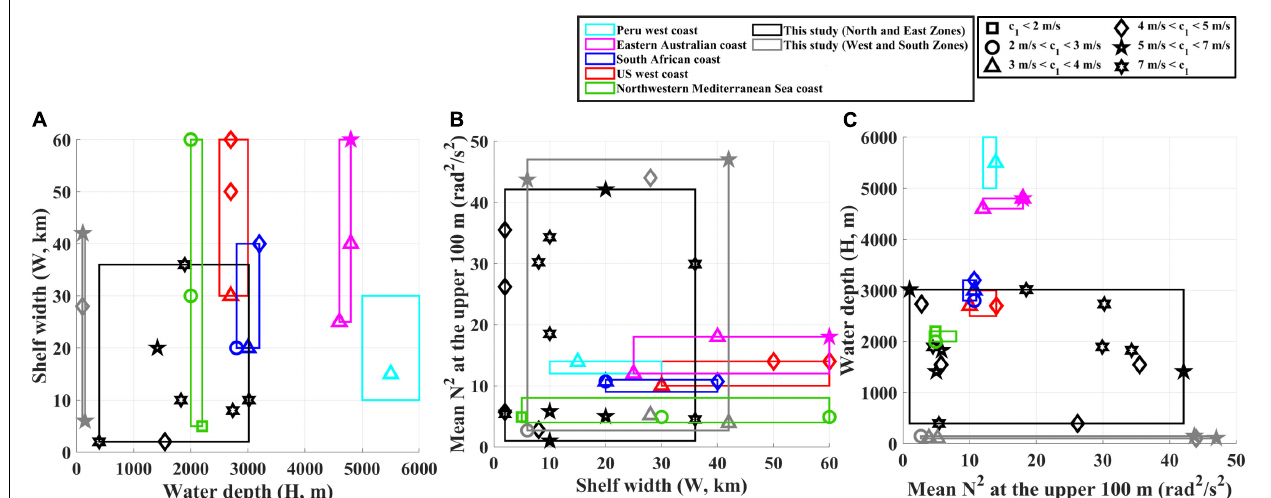
FIGURE 9 | Comparison of mode-1 CTW phase speeds or MPS (range of c 1 denoted with symbols in the upper right box) derived from this (black: North and East Zones; gray: West and South Zones) and other studies (colors) as functions of the (A) water depth ( H ) and shelf width ( W ), (B) shelf width ( W ) and N 2 averaged ( M ) over the upper 100 m, and (C) N 2 averaged ( M ) over the upper 100 m and water depth ( H ). Studies on CTWs off the west coast of the United States (red) (Battisti and Hickey, 1984), South African coast (blue) (Schumann and Brink, 1990; Illig et al., 2018), west coast of Peru (cyan) (Brink, 1982; Illig et al., 2018), north-western Mediterranean Sea coast (green) (Jordi et al., 2005), and Eastern Australian coast (Church et al., 1986), are shown for